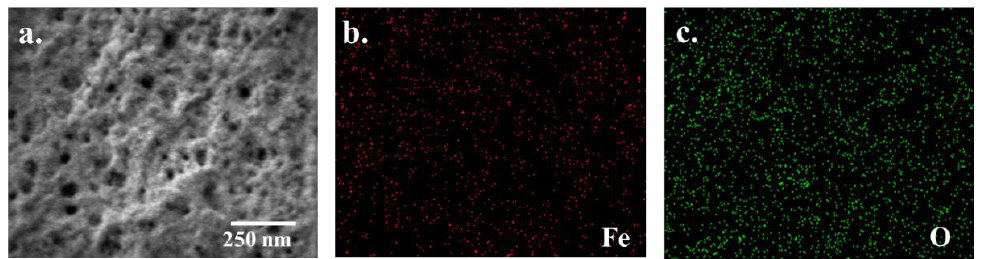
Figure 2. FE-SEM image of the MMIP – gluten electrode ( a ) and EDS images of iron(II) ( b ) and oxygen ( c